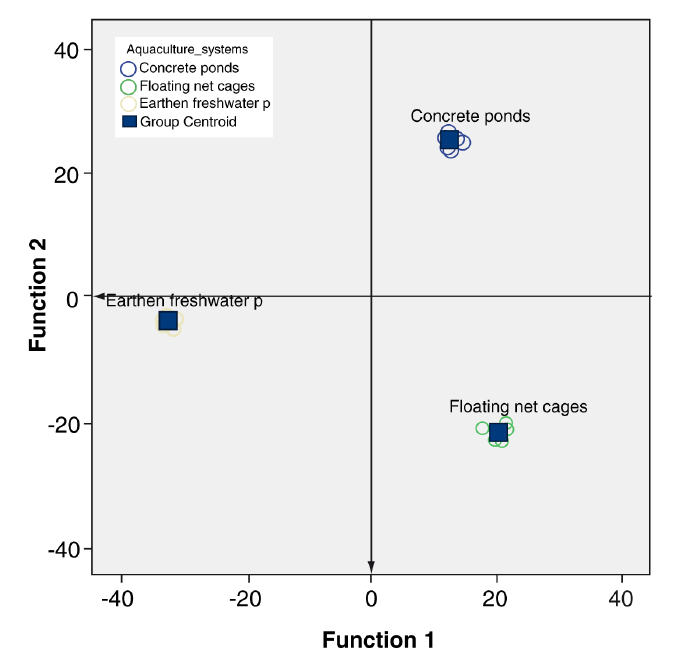
Figure 6. Sample centroids of discriminant function scores based on water quality